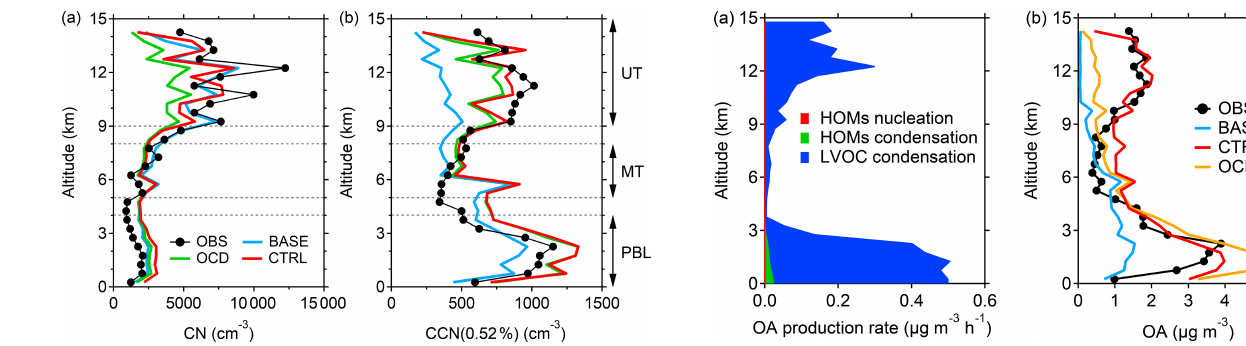
Figure 1. Comparison of observed and simulated number con- centrations of (a) condensation nuclei (CN, total aerosol popula- tion) with diameters above 20nm and (b) cloud condensation nuclei (CCN) at 0.52% supersaturation. The aerosol concentrations are at standard temperature and pressure (STP; 273.15K and 1000hPa). Planetary boundary layer (PBL), middle troposphere (MT), and up- per troposphere (UT) are defined as the altitude range of 0–4, 5–8, and 9–15km, respectively. The standard deviations of the observa- tions are provided in Table A4.